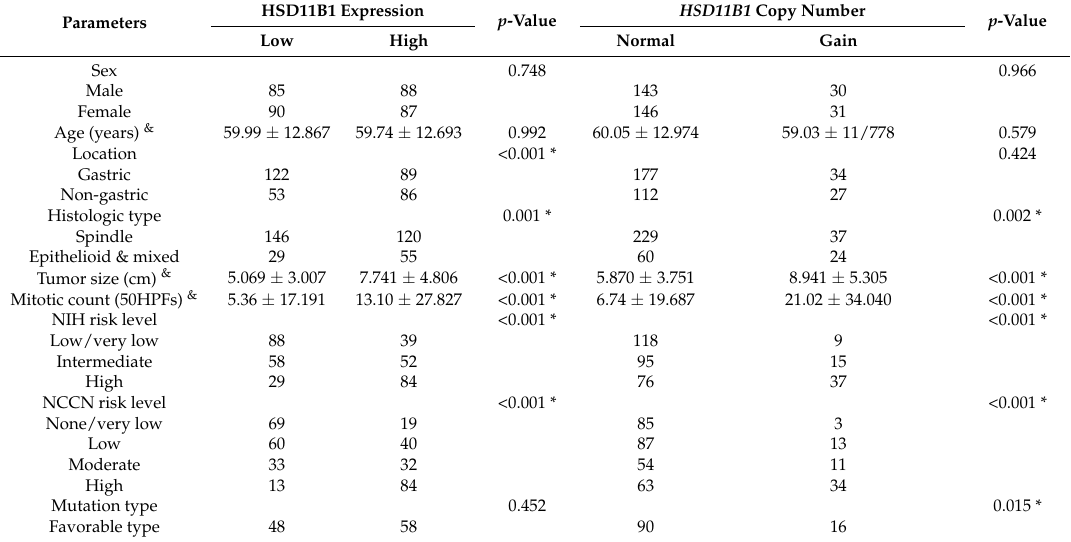
Table 1. Associations of HSD11B1 expression and HSD11B1 gene copy number with various clinicopathological parameters in 350 GIST